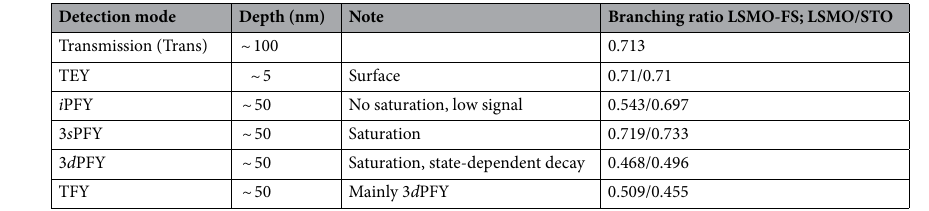
Table 1. The probing depth of different detection